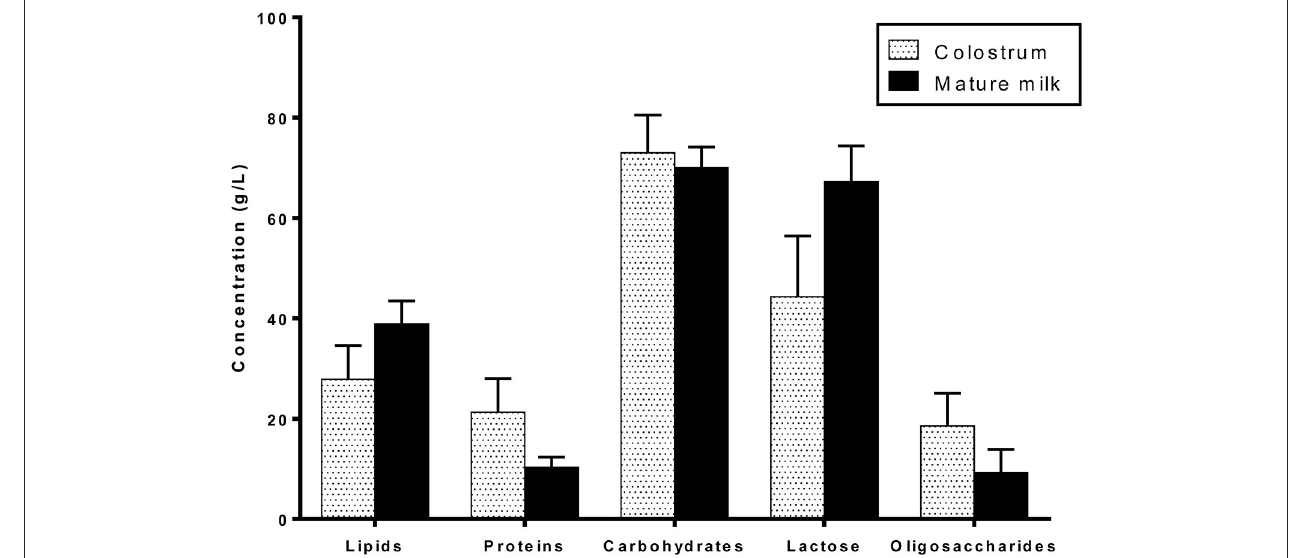
FIGURE 1 | Macronutrient composition of colostrum and mature term human milk.